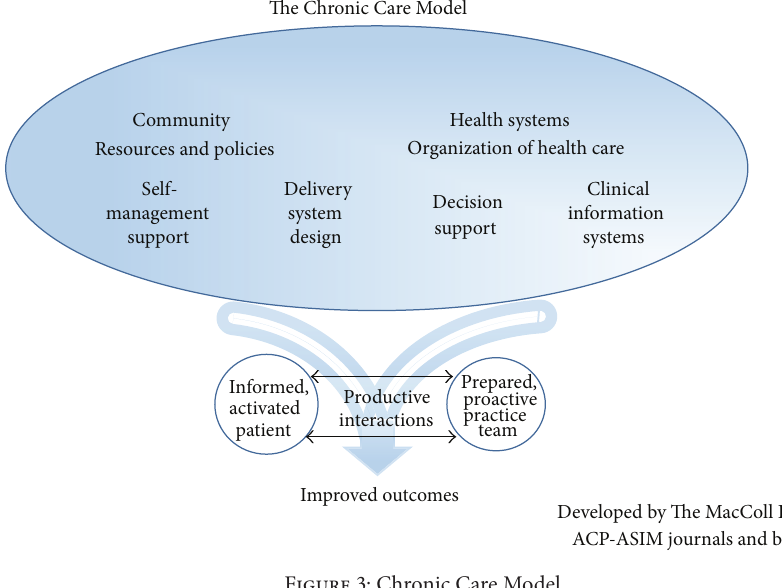
Figure 3: Chronic Care Model. Table 2: Baseline study participant